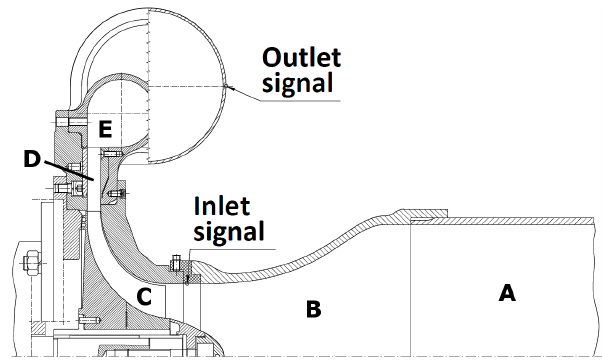
Figure 1: Cross section of the experimental rig used in this study